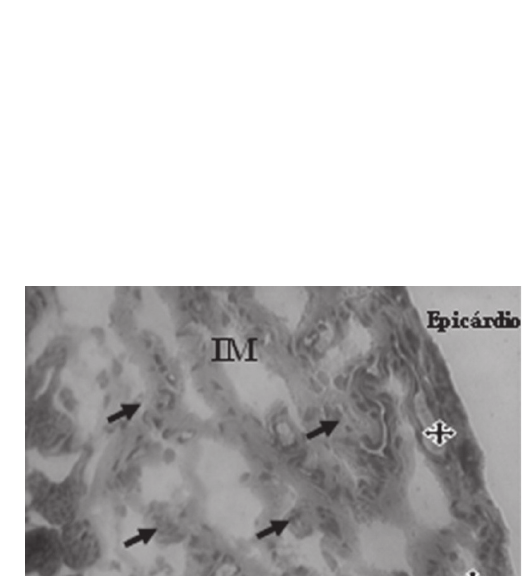
Fig. 3 - Neovasos com lúmen (estrela) e células endoteliais (flechas), após o transplante de células mononucleares no infarto do miocárdio (IM) - Tricrômio de Gomery, x200